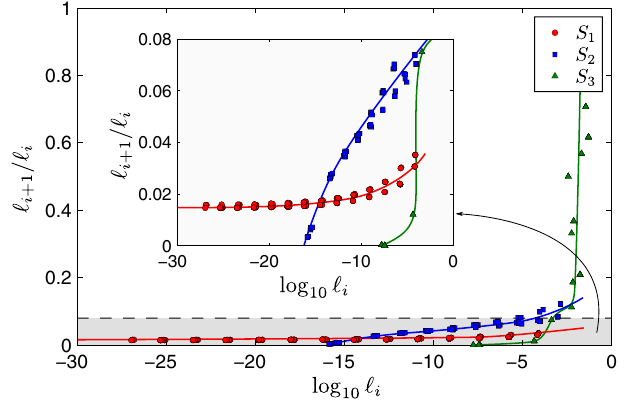
= l FIG. 9. Ratio l i i of consecutive basin interval lengths for þ 1 the roulette system as a function of l i . The inset shows a magnification of the region shaded in gray. For each shape of the roulette surface ( S 1 , S 2 , or S 3 ), ten realizations of the (random) process described in Appendix F are superimposed. The curves are to guide the